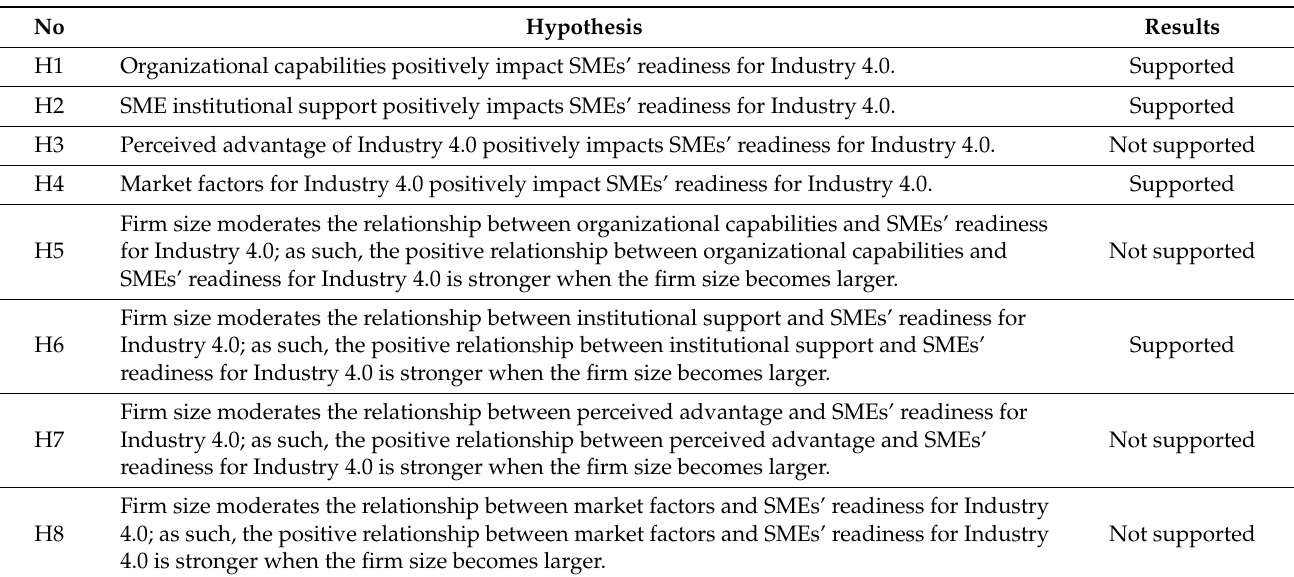
Table 17. Summary of results for